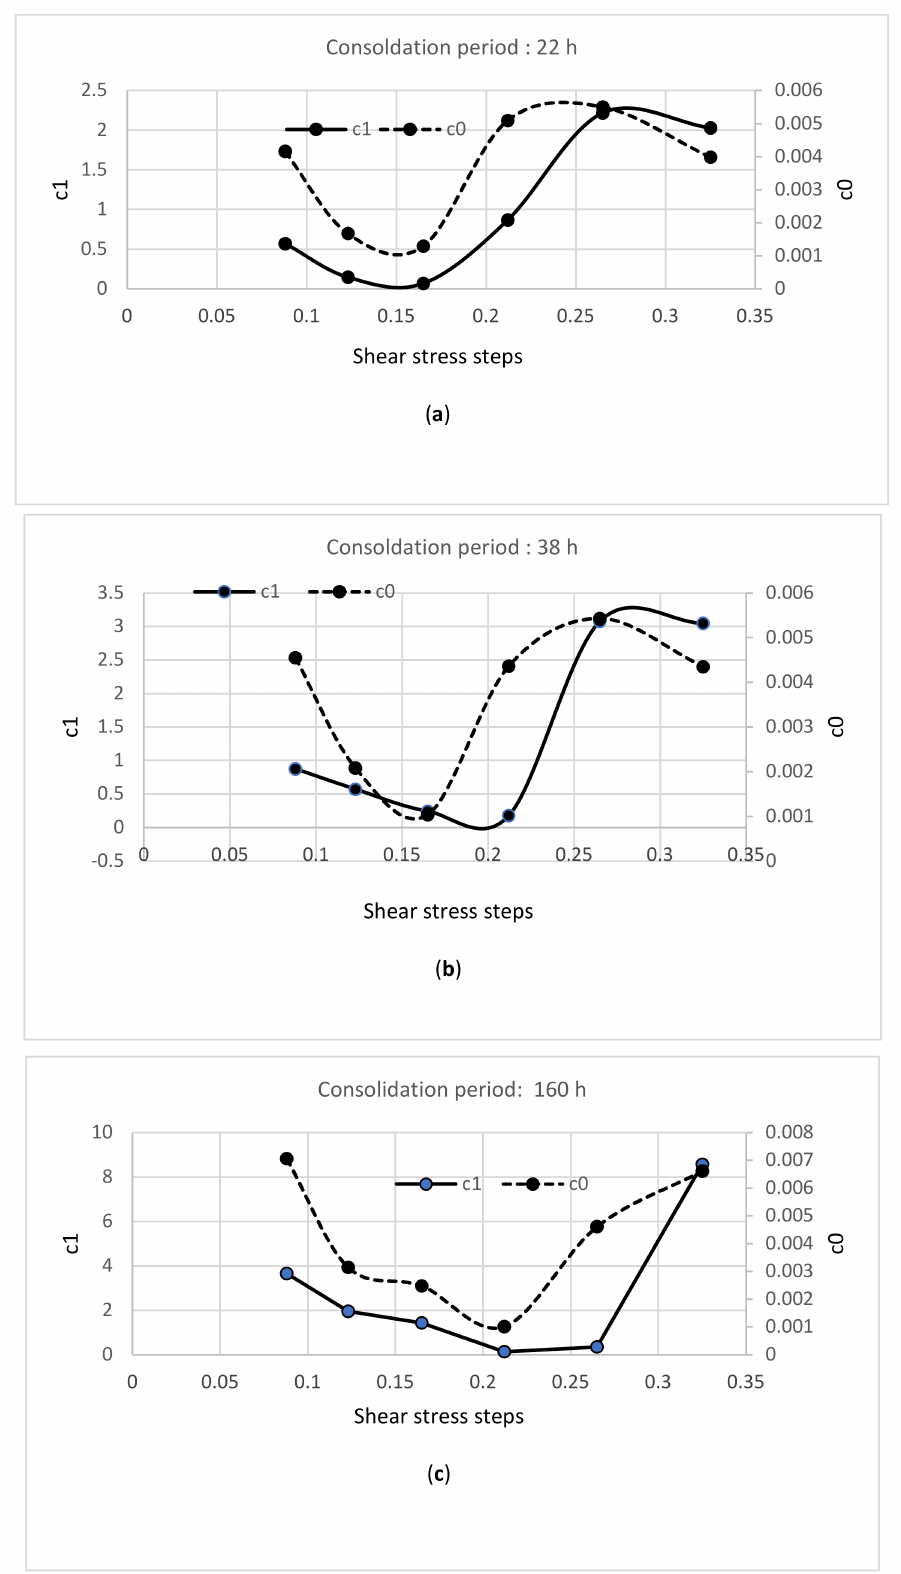
Figure 7. The variability of the fitting constants as a function of shear stress and age of deposit ( a ): 22 h; ( b ): 38 h and ( c ): 160